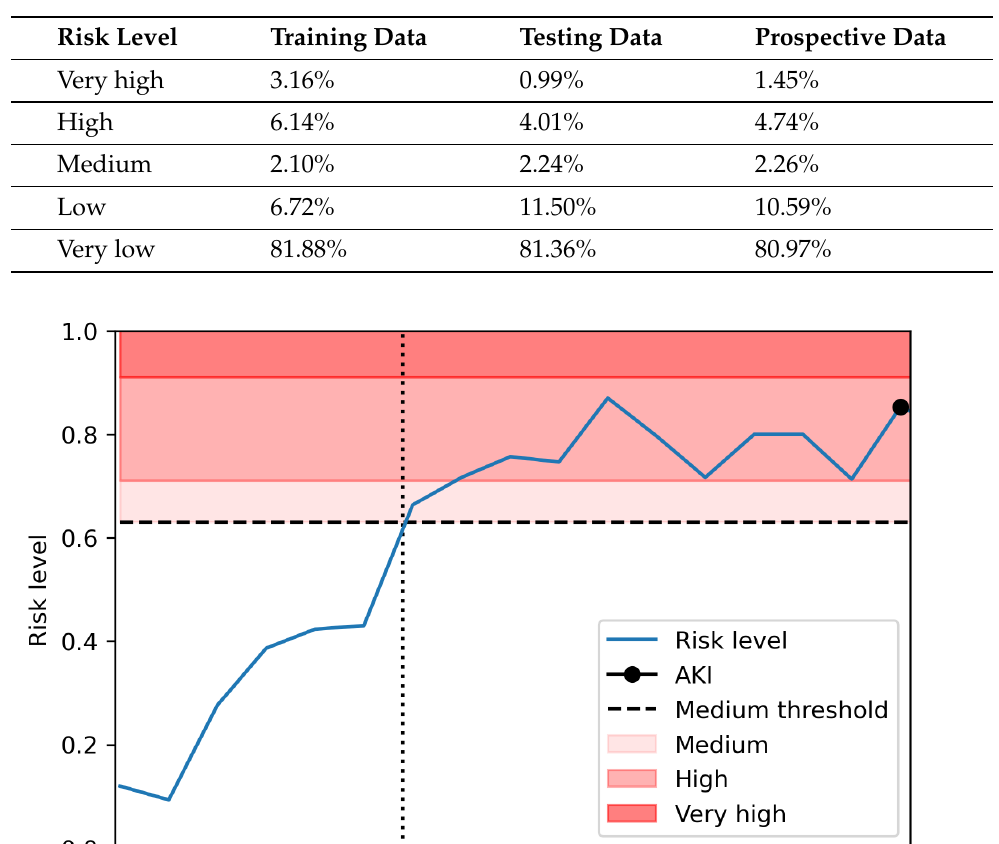
Table 3. Proportion of predictions at each risk level for training, test and prospective data. We see that the proportions are fairly consistent across the testing and prospective data but vary from the training data. The proportions for the ‘Very low’ risk level are consistent across the three samples, suggesting that the performance of the model in identifying those at low AKI risk in reality has similar accuracy to the trained case.